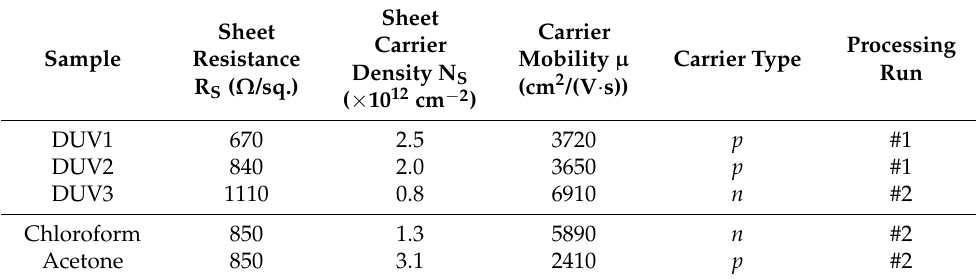
Table 2. Electrical properties of graphene samples prepared by different methods.